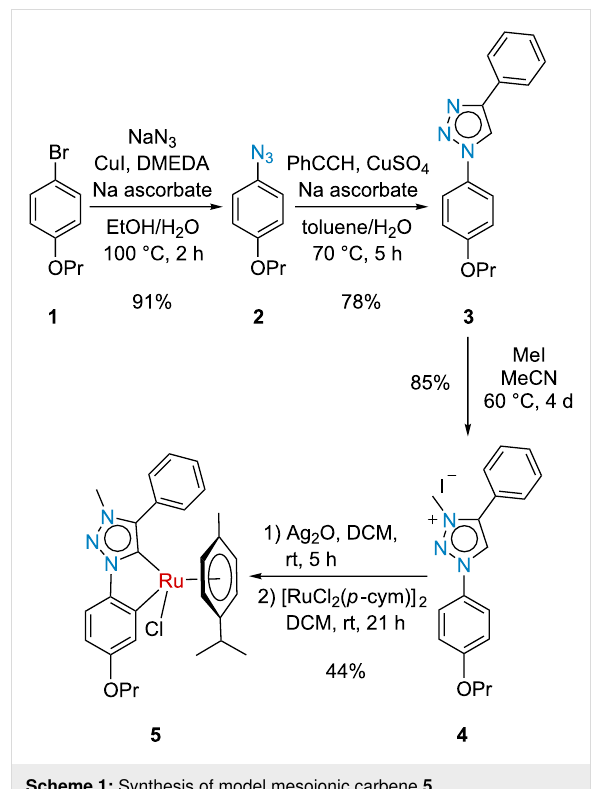
Figure 3: Concept of cyclometalated calix[4]arene target.